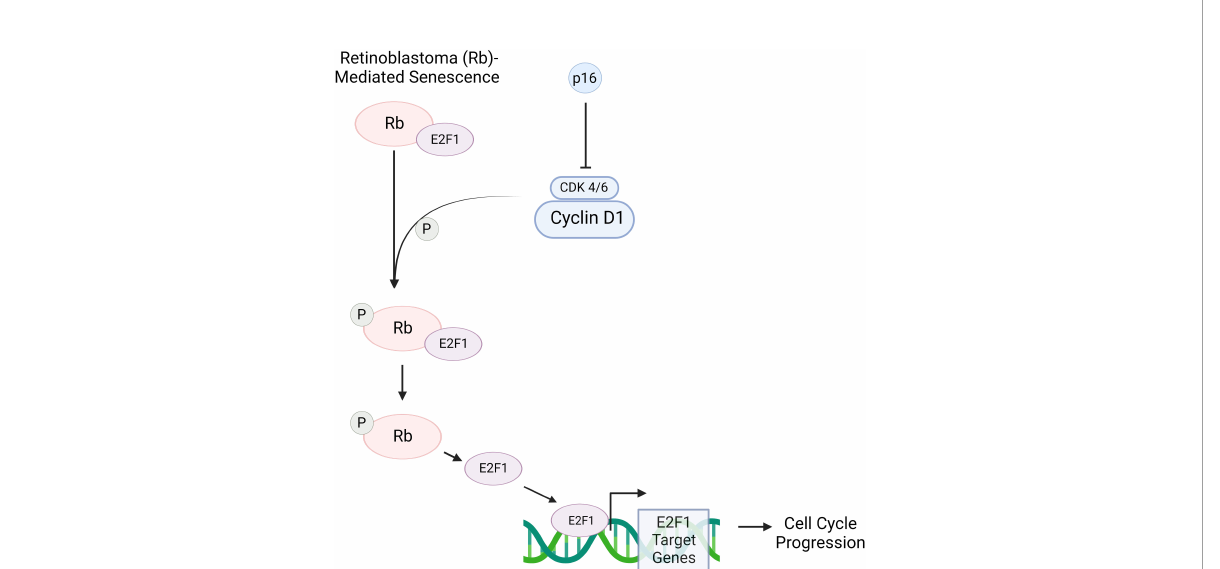
FIGURE 3 p16 is a protein that, when in increased concentrations, can induce senescence via the retinoblastoma (RB)- pathway. Rb is a tumor suppressor protein that plays a critical role in regulating the cell cycle. Cyclin D1 activates cyclin-dependent kinase 4/6 (CDK 4/6), allowing the kinase to phosphorylate the Rb-E2F1 complex. This complex consists of the Rb protein and E2F1 transcription factor. When phosphorylated, Rb is inactivated, allowing for the detachment of E2F1; consequently, E2F1 target genes are transcribed. These play a crucial role in the transition of a cell from the G1 to S phase. However, in the presence of p16, CDK 4/6 ’ s ability to deactivate Rb through phosphorylation is inhibited. As a result, E2F1 remains bound to Rb, and therefore transcription of E2F1 target genes is prevented. This blocks cell cycle progression, thus causing a cell to move towards senescence. Created with